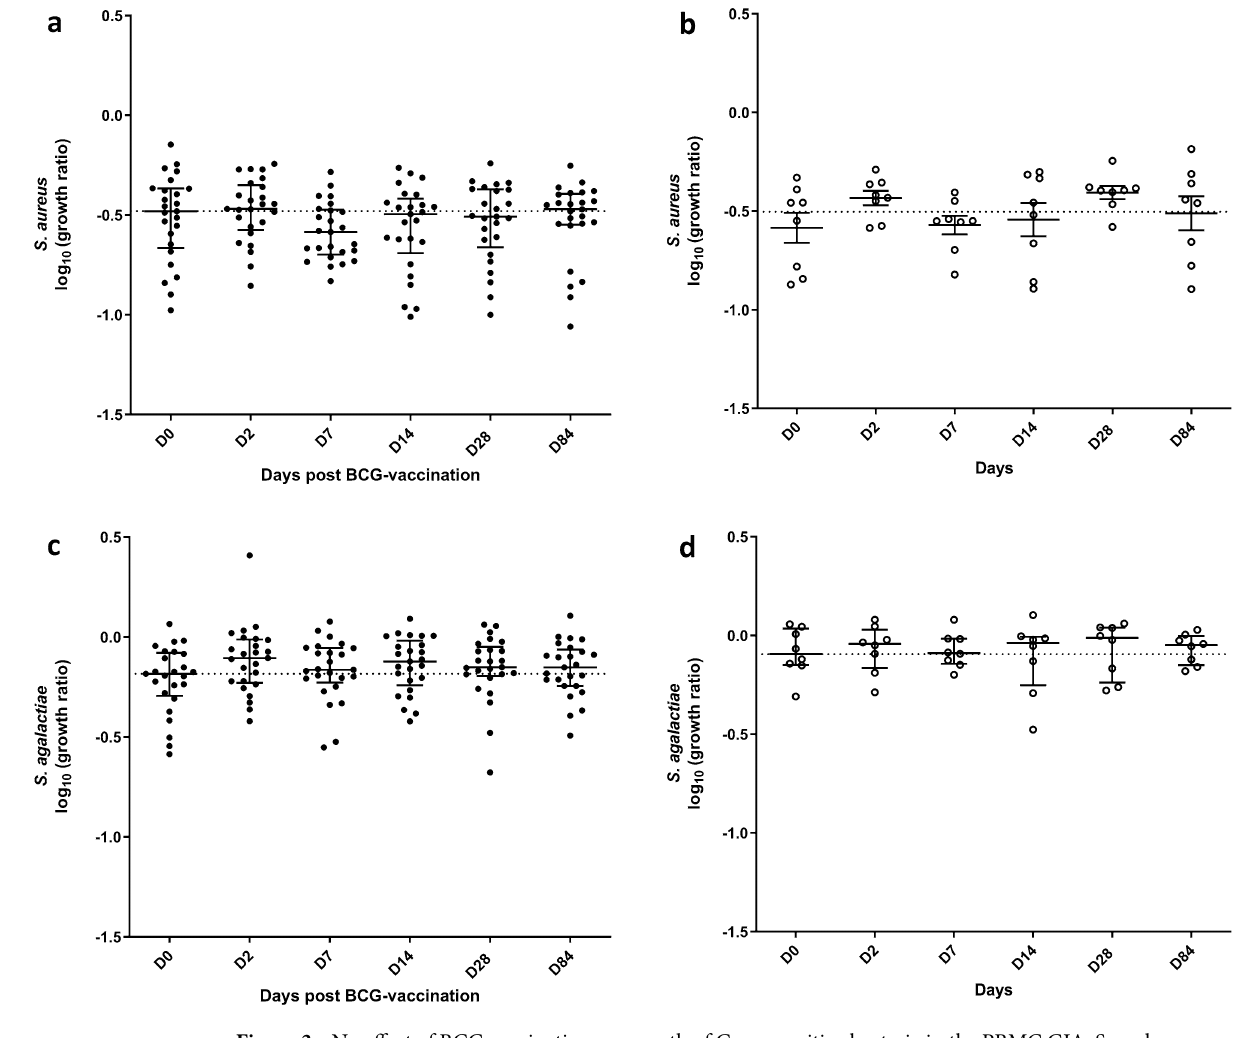
Figure 3. No effect of BCG vaccination on growth of Gram-positive bacteria in the PBMC GIA. Samples were taken from volunteers enrolled into phases 1 and 2 combined. Healthy UK adults were randomised to receive BCG vaccination ( n = 27) or to be unvaccinated controls ( n = 8). PBMC bacterial GIAs were conducted on samples taken at baseline and days 2, 7, 14, 28 and 84 following BCG vaccination (closed circles) and at the same time-points in unvaccinated control individuals (open circles). PBMC and autologous serum were co-cultured with S. aureus ( a, b ) or S. agalactiae ( c, d ) for 1 h after which time cells were lysed and bacteria quantified by plating on solid blood agar. Bars represent the median values with the interquartile range (IQR); dotted lines indicate the baseline